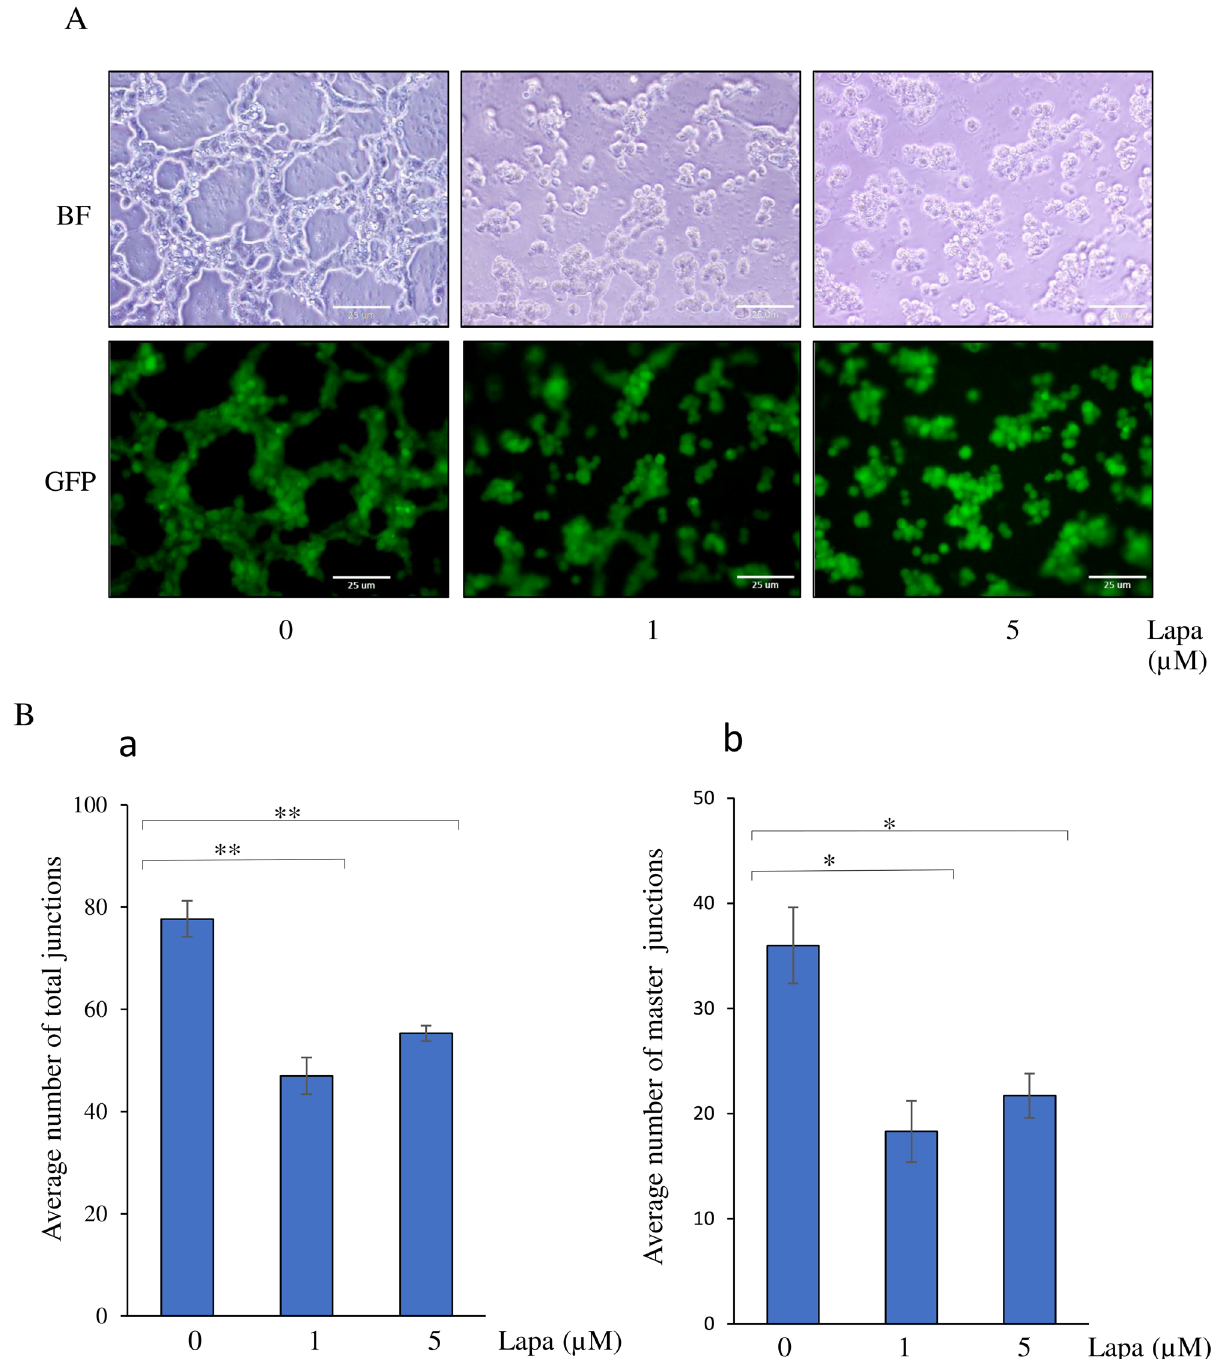
Figure 5. The effect of lapatinib on tube formation ability of miPSCs cultured in CM. ( A ) Representative bright field and fluorescence images of tube-like structures of miPSCs cultured in different conditions of treatment exhibiting the inhibition of formation of tube-like structures in the presence of lapatinib. Scale bars = 25 µm. ( B) Bar graphs showing the average number of total junctions ( a ) and master junctions ( b ) formed by cells. *, p < 0.005; **, p <